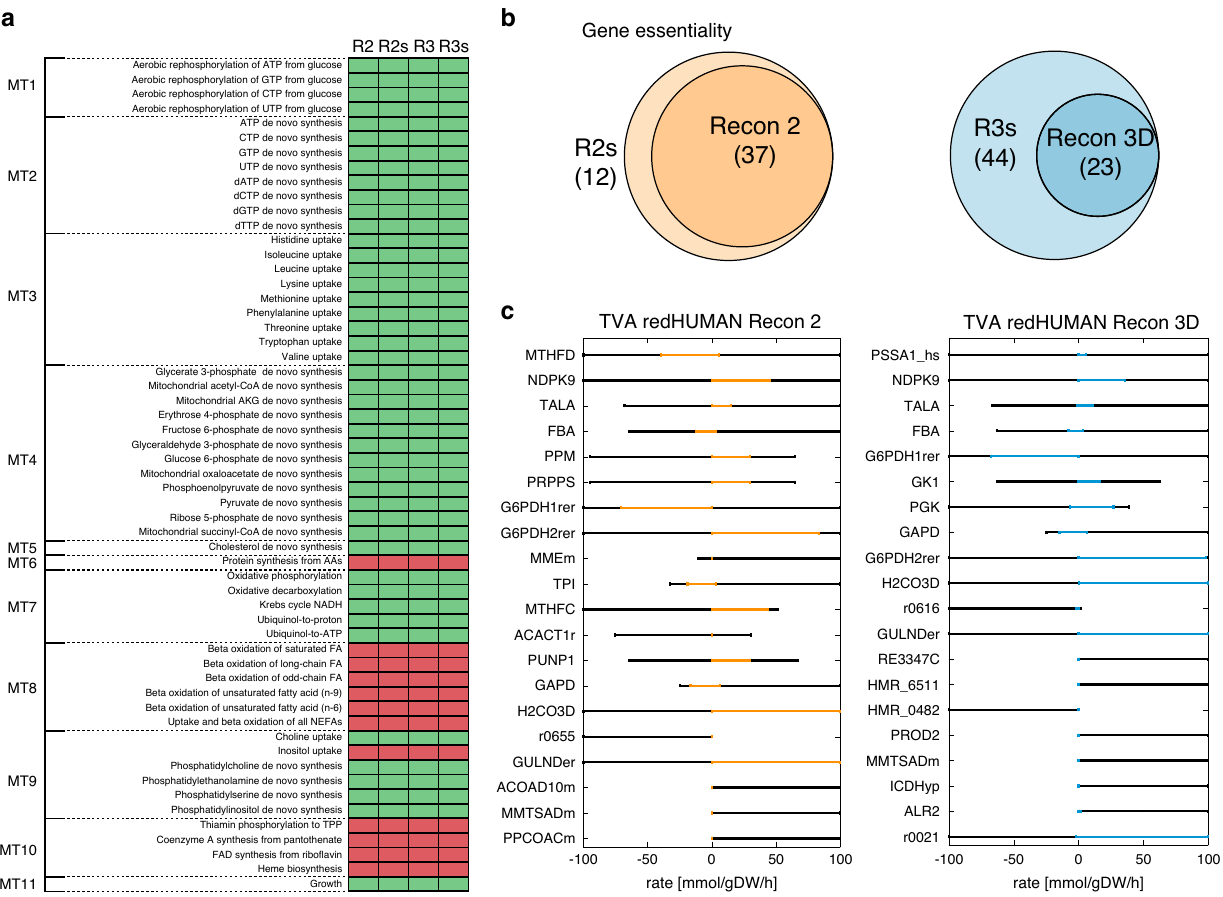
Fig. 5 Model validation through metabolic tasks and consistency checks. a The 57 metabolic tasks tested in the generated reduced models. R2, R3: Recon 2, Recon 3D reduced model with one lumped reaction per BBB. R2s, R3s: Recon 2, Recon 3D reduced model with Smin. Classi fi cation of metabolic tasks in those captured by the models (green) and those not captured by the models (red). MT1: rephosphorylation of nucleoside triphosphates, MT2: de